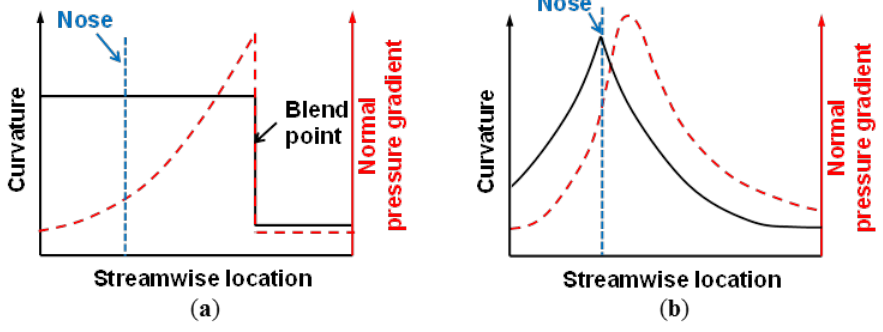
Figure 29. Schematic streamwise variation of curvature and normal pressure gradient at a positive effective incidence: ( a ) Circular LE; ( b ) Continuous-curvature